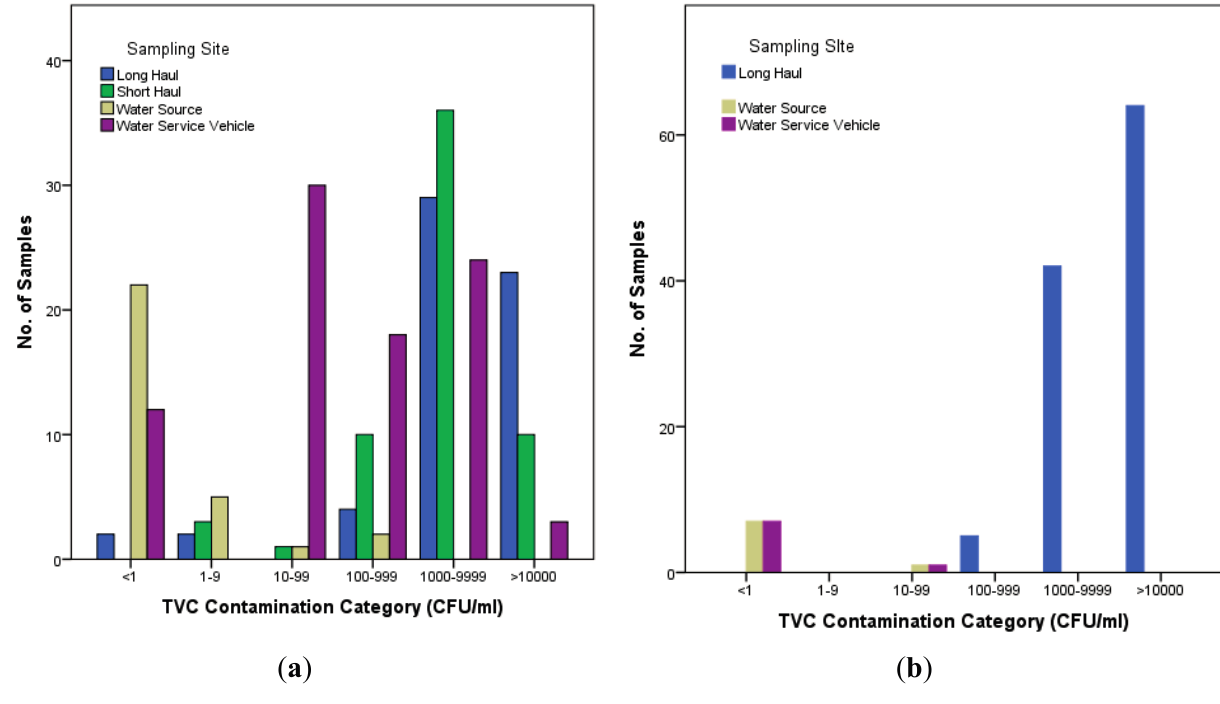
Figure 1. The distribution of TVC contamination categories by Sampling Activity .